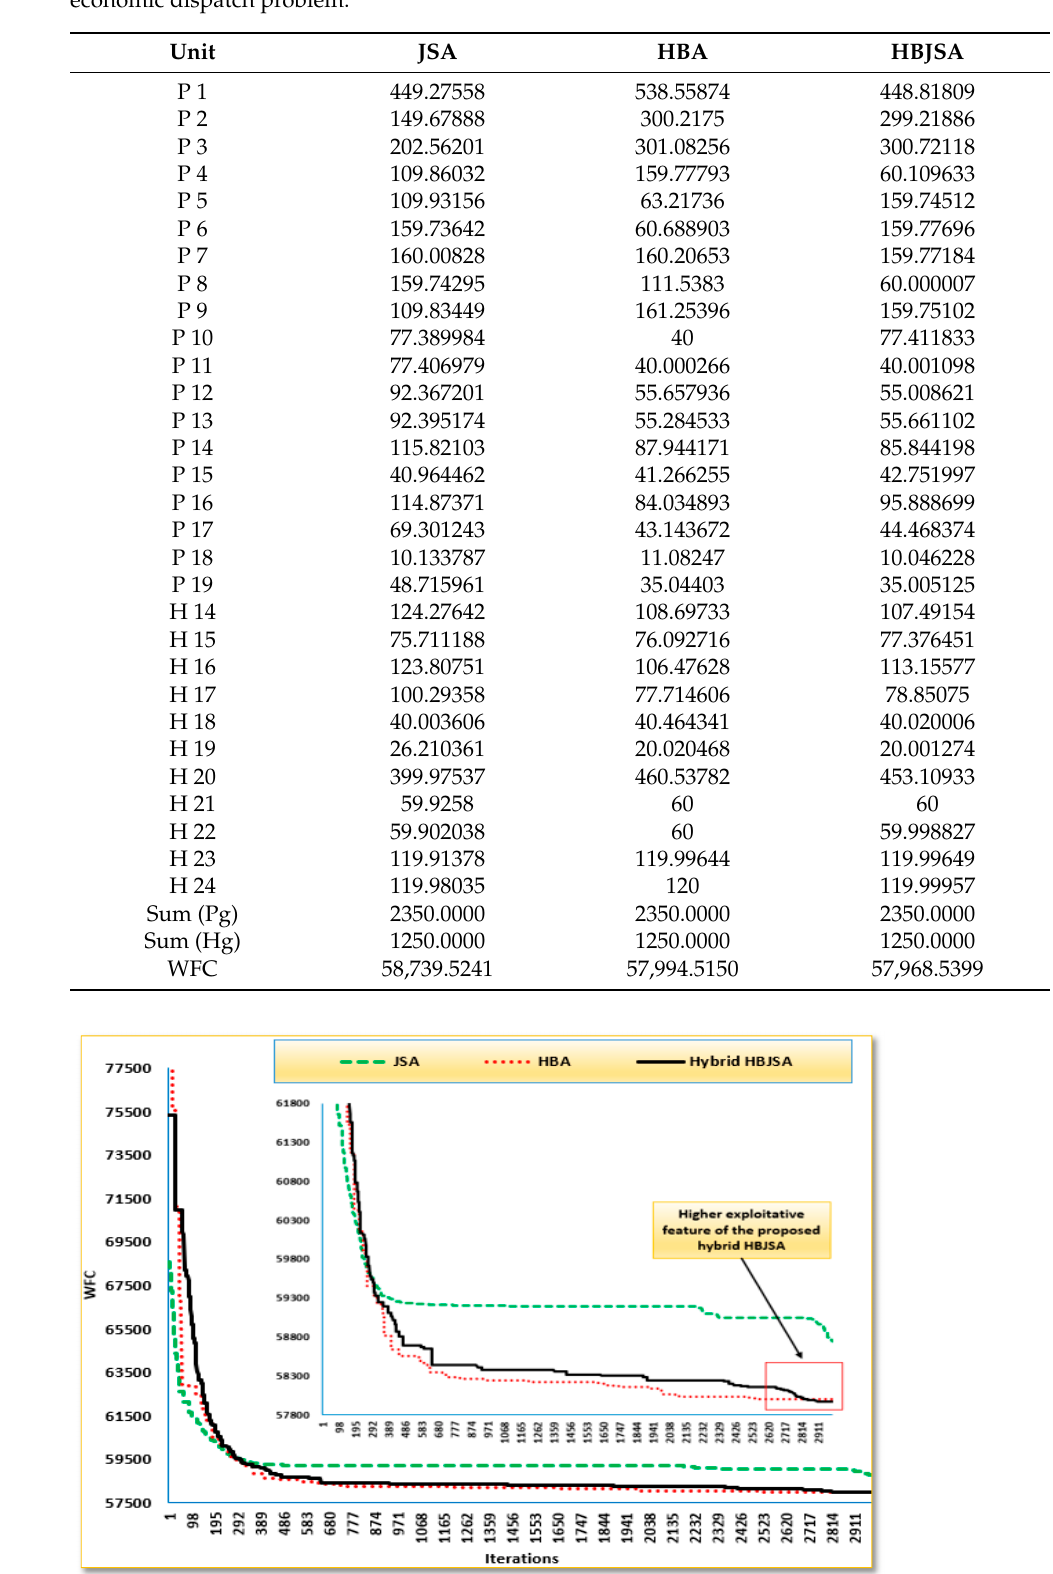
Figure 5. Convergence characteristics of the proposed HBJSA versus the HBA and JSA for the 24-unit system of CHP economic dispatch. Table 2. Comparison between HBA, JSA, and HBJSA with respect to reported techniques for the 24-unit system of CHP economic dispatch.